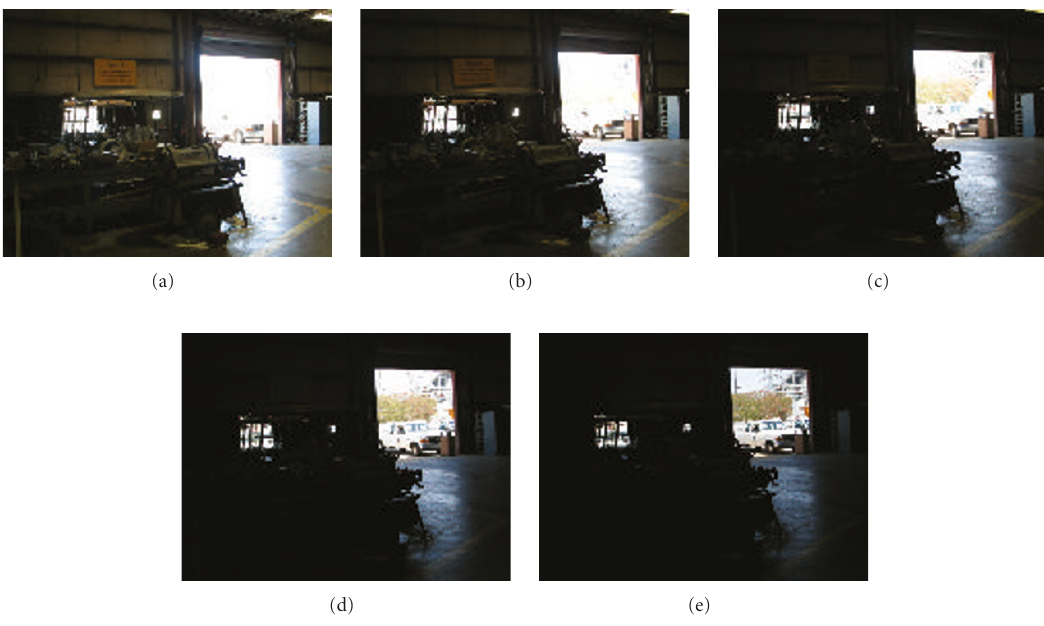
Figure 7: Five images of “Facility I” data set that includes 22 images are displayed here. Exposure durations of (a)–(e) are 1 / 25, 1 / 50, 1 / 100, 1 / 200, and 1 / 400 seconds,